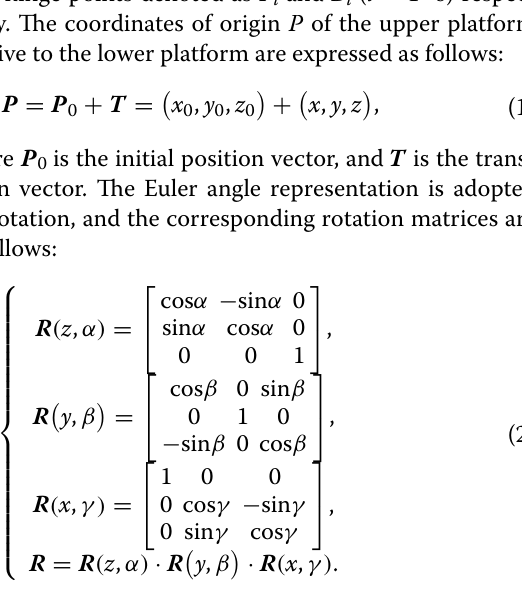
with a power of 750 W. A mechanical schematic diagram of G-Balance is shown in Figure 4.